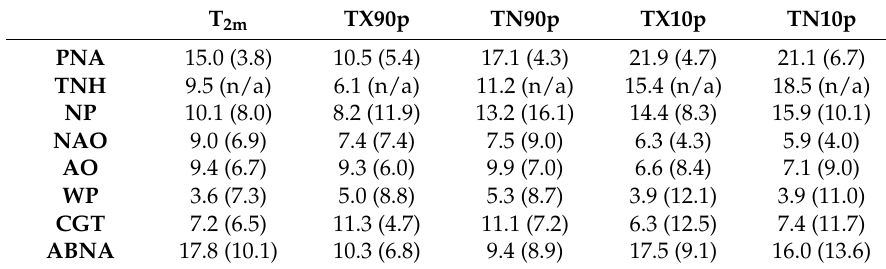
Table 3. Percentages of North American T 2m variance and temperature extreme variances explained by the teleconnections considered. Numbers outside and inside parentheses are the results in DJF and JJA, respectively. T